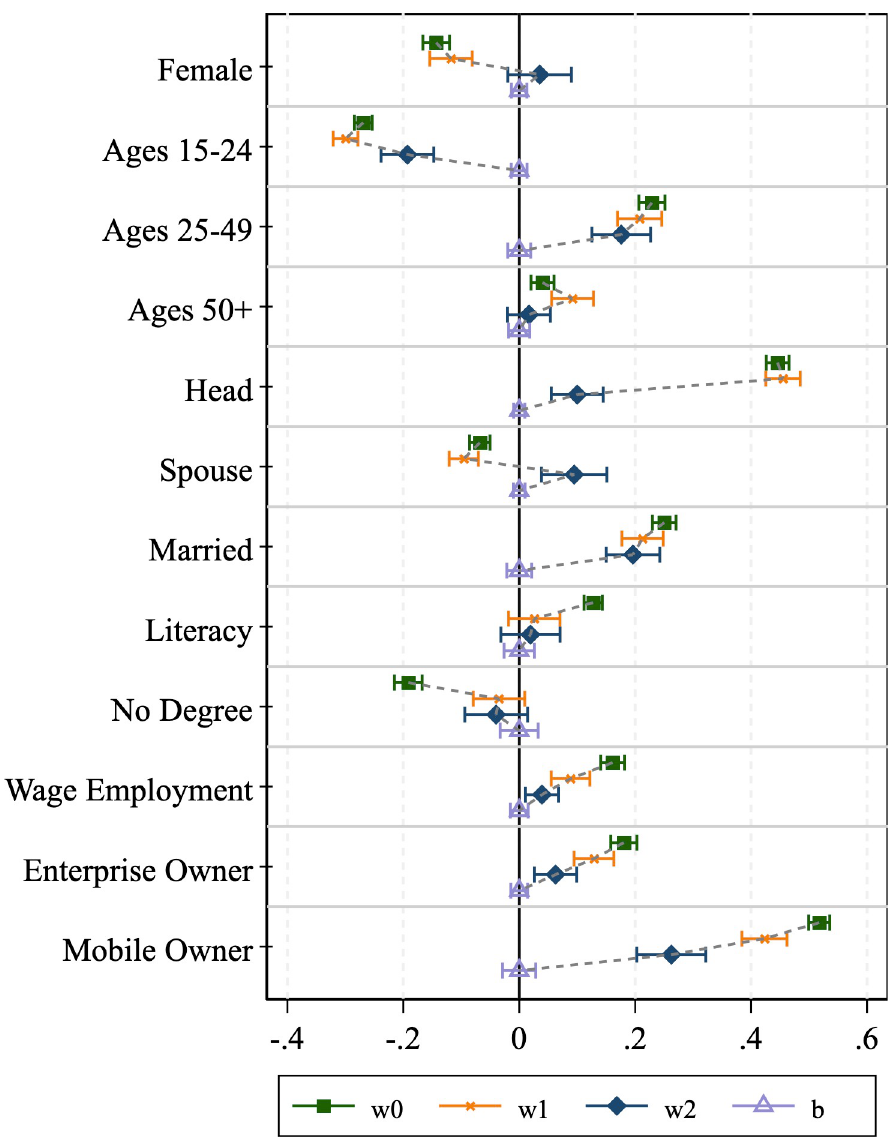
Fig 2. Graphical inspection of bias adjustment,